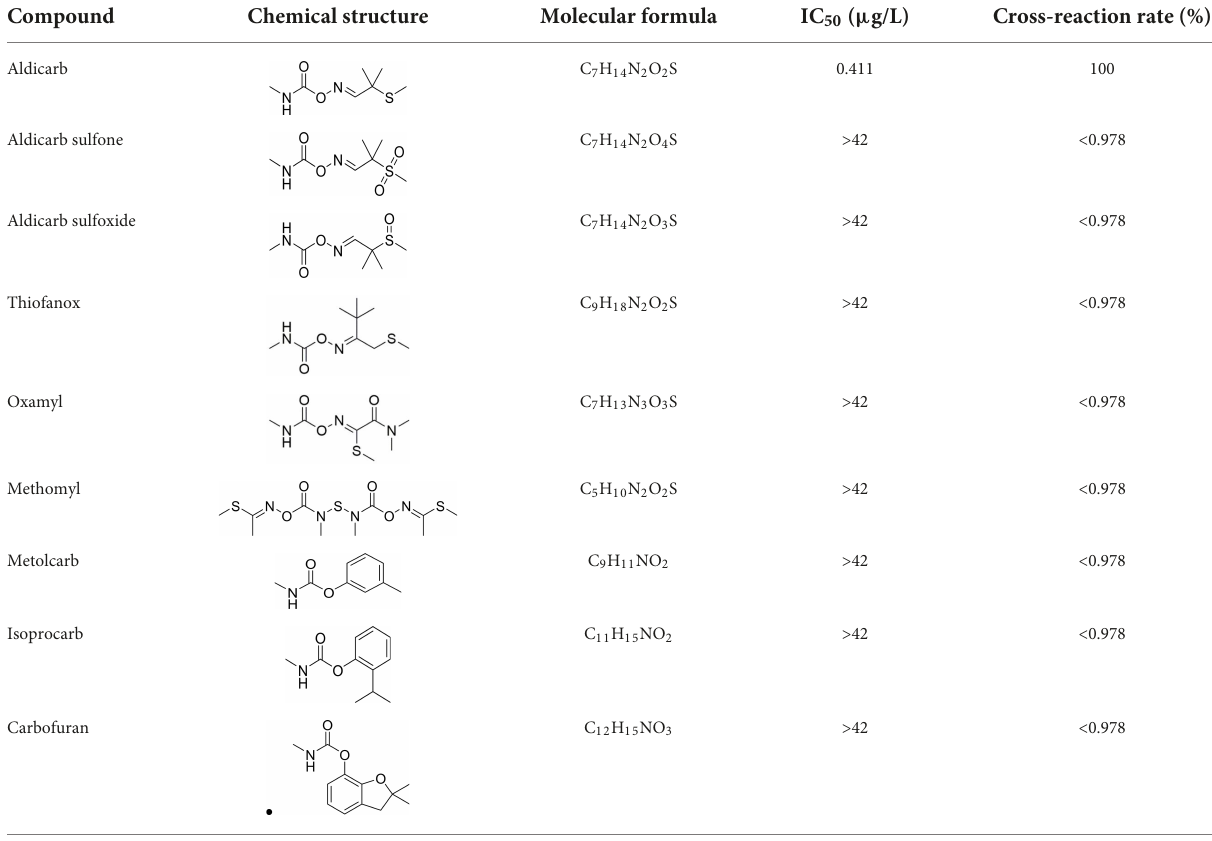
TABLE 2 Cross-reactivity rates of anti-aldicarb monoclonal